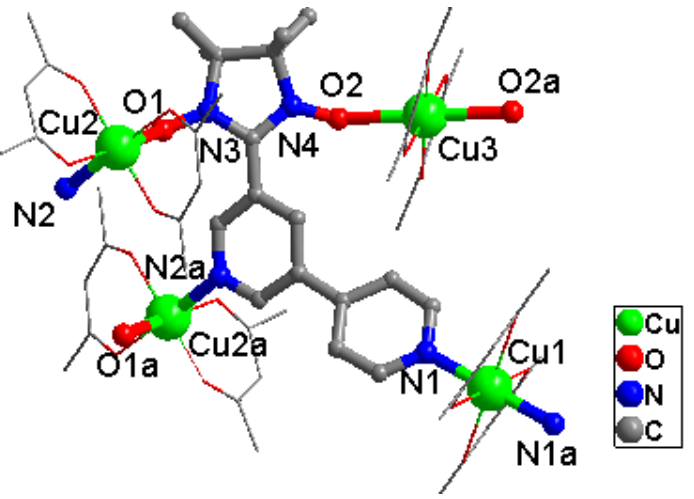
Figure 3. Asymmetric unit of the reticular complex in 2 , in which the H and F atoms are left out (a: − x, − y + 2, − z − 1).